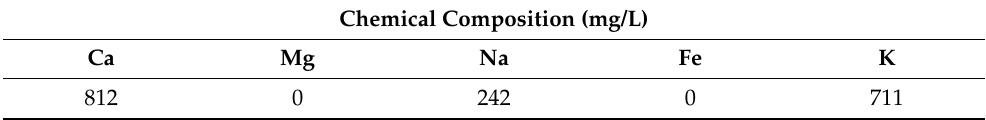
Table 2. Chemical composition of concrete slurry waste (obtained by XRF spectroscopy).